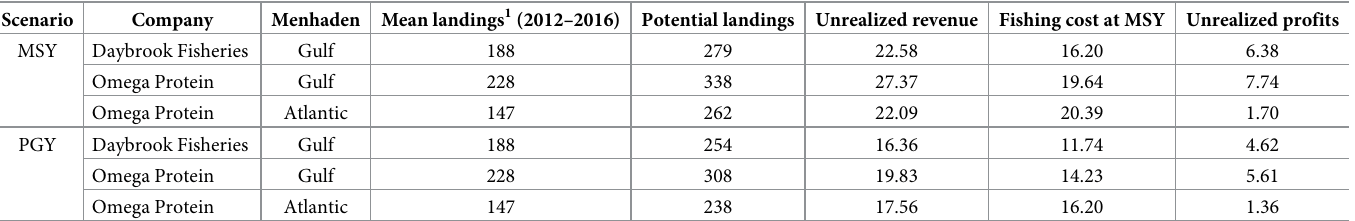
Table 7. Average landings (10 3 t), potential MSY (10 3 t), and associated unrealized revenues (USD 10 6 ) for menhaden by the major fishing companies in the USA. Scenario